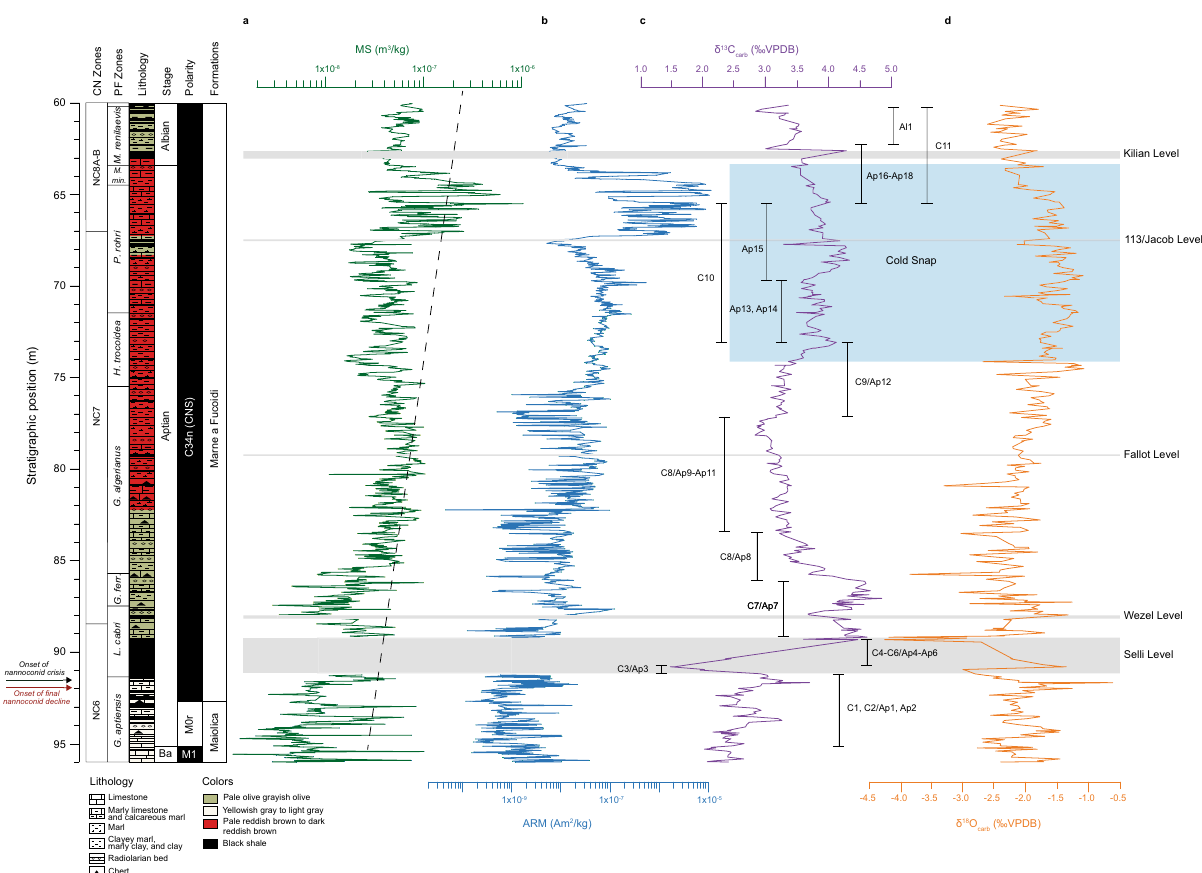
Fig. 2 Integrated stratigraphy of the studied interval at PLG core. Stratigraphic framework of the PLG core with stratigraphic depths. Depths for the upper boundaries of the planktonic foraminiferal and calcareous nannofossil zones, and nannoconid decline and crisis biohorizons identi fi ed in the PLG core 11,32 and this work. Changes in ( a ) magnetic susceptibility (MS) (dark green) with detrending linear (black-doted line); b anhysteretic remanent magnetization (ARM) (blue); c δ 13 C (purple). Codes for C/Ap-isotope segments 7,33 . d δ 18 O (orange). The gray bands highlight the Selli, Wezel, Fallot, 113/Jacob and Kilian Levels. The blue band in the stable isotope data represents the cold snap interval. Ba. Barremian, M. Microhedbergella , min. miniglobularis, P. Paraticinella, H. Hedbergella, G. Globigerinelloides, ferr. ferreolensis, L. Leupoldina